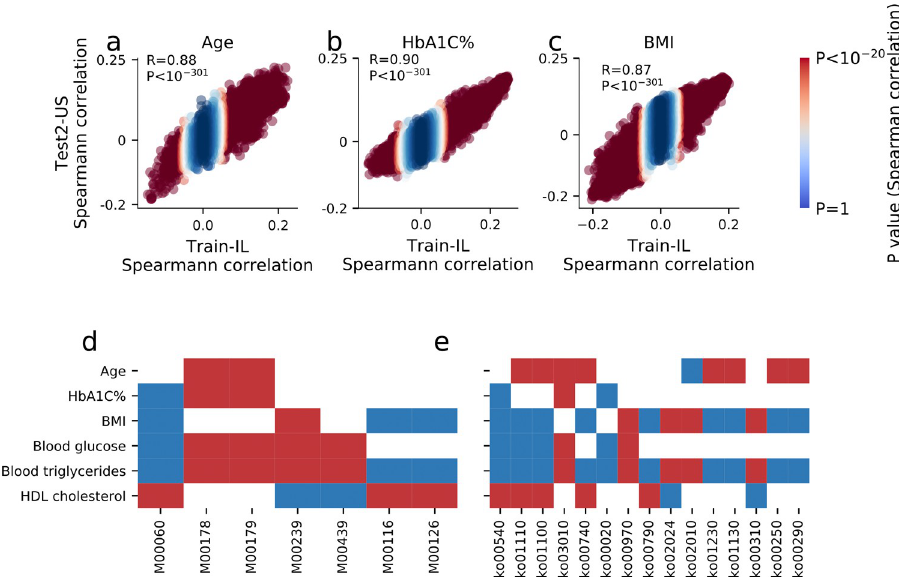
Fig 6. Functional analysis of modules and pathways. (a)-(c) Spearman correlation of each KEGG KO gene with age, HbA1C% and BMI in the Israeli training cohort (x-axis, N = 27,075) and the U.S. test cohort (y-axis, N = 3,974). The correlation and P-value between the correlation coefficients of each cohort are shown. Uniref are colored according to the P-values of the Spearman correlation coefficients in the Israeli cohort. (d)-(e) Heat map displaying only significant positive (blue) or negative (red) association between 6 phenotypes and top associated KEGG KO modules (d) or pathways (e). M00060 is the KDO2-lipid A biosynthesis, Raetz pathway, LpxL-LpxM type. M00116 the